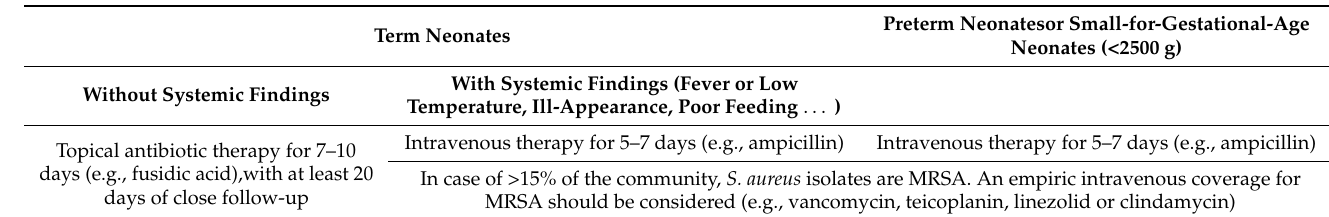
Table 2. Our suggested approach to initial antibiotic therapy for suspected Staphylococcal infections in neonates.